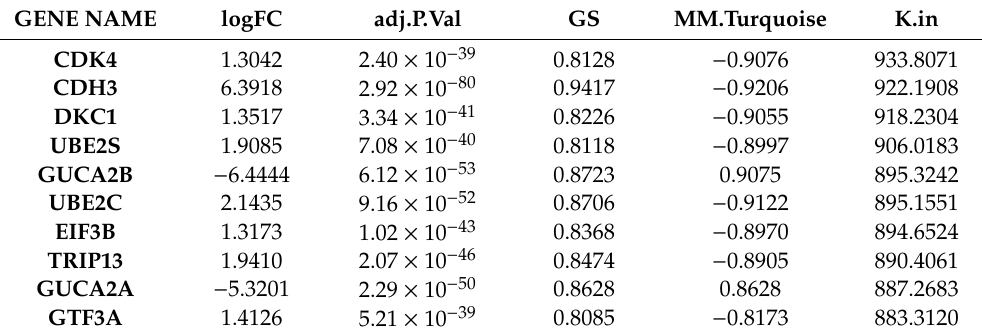
Table 3. Top 10 genes with the highest intramodular